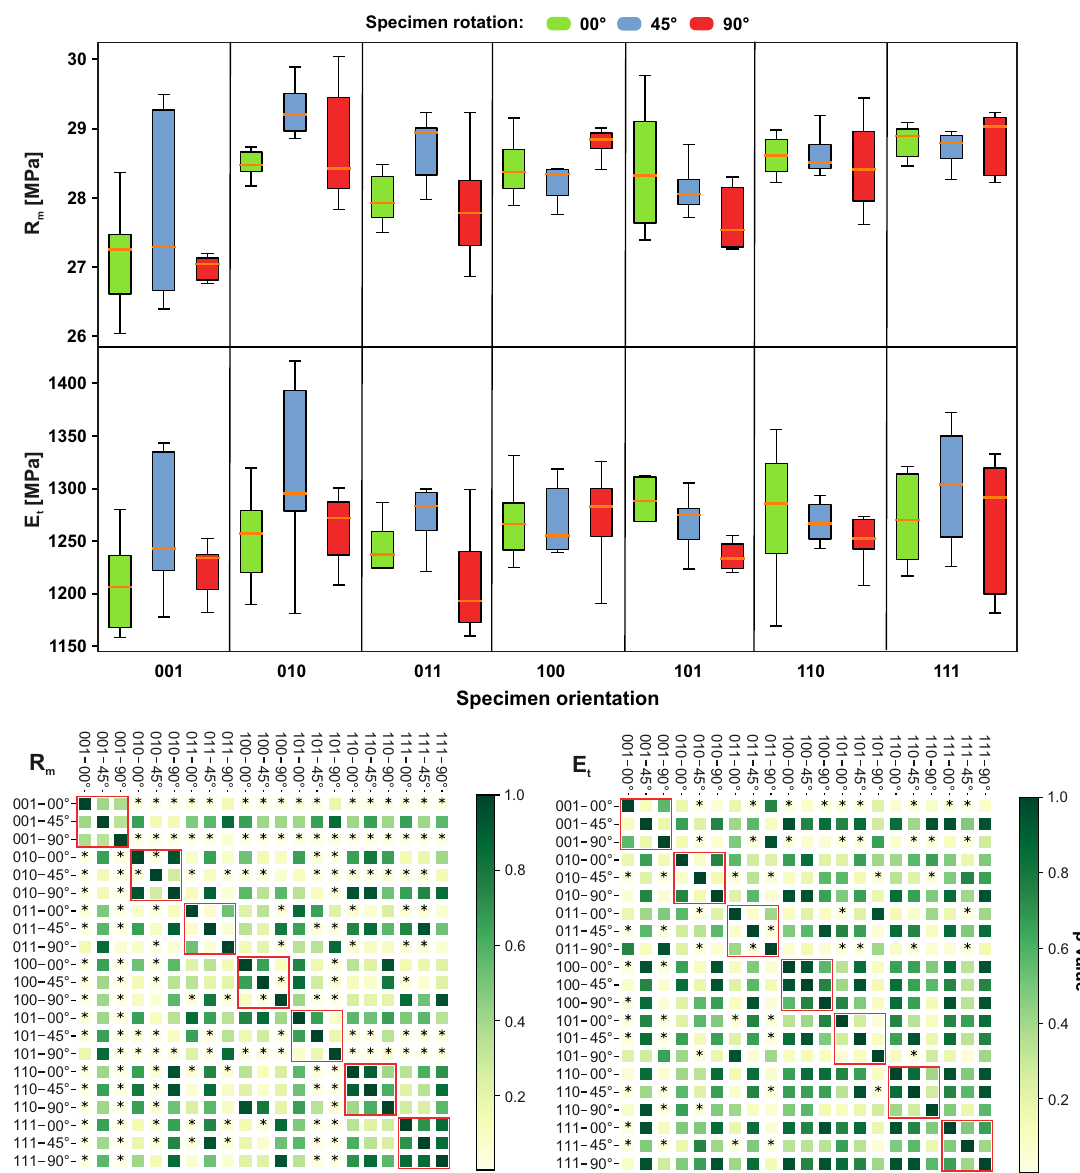
Figure 12. Impact of different sample orientations on Young’s modulus ( E t ) and ultimate tensile strength ( R m ) values. The red border in the heatmap highlights specimens with equal orientation. The members marked as * express statistically significant